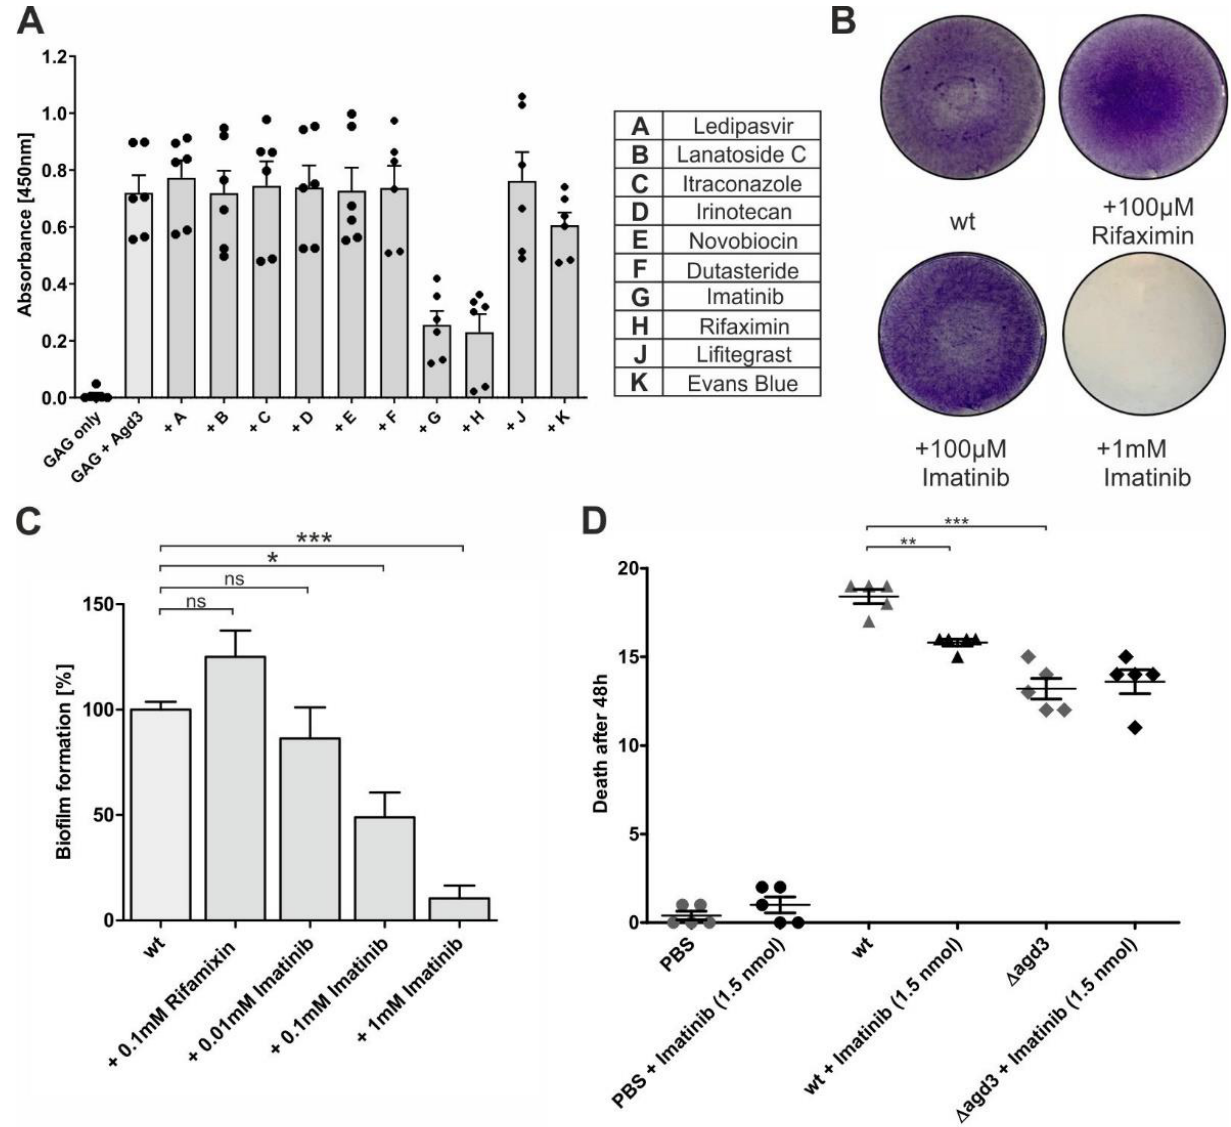
Figure 4. Inhibition of Agd3 activity by imatinib and rifaximin. ( A ) Ten potential inhibitors selected by molecular docking screening were tested at a 100 µ M concentration in a GAG ELLA assay (n = 3). ( B ) Effect of 100 µ M imatinib or rifaximin on AfS35 biofilm visualized by crystal violet staining. ( C ) Quantification of the biofilm staining via absorbance measurement (n = 3). ( D ) Testing of imatinib in a Galleria mellonella infection model. Groups of 20 larvae were injected with 15 µ L containing PBS, PBS + 1.5 nmol imatinib, 10 6 spores of Af S35 strain (wt), 10 6 spores of Af S35 strain + 1.5 nmol imatinib, 10 6 spores of Δ agd3 , or 10 6 spores of Δ agd3 + 1.5 nmol imatinib. The experiment was performed with n = 5 from four different larvae batches and statistical analysis was run by one-way